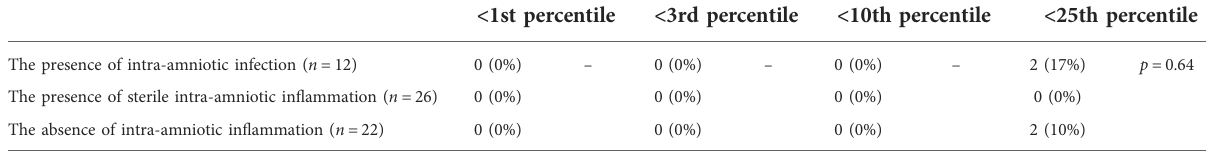
TABLE 3 The rates of newborns with birth weights, expressed as percentiles derived from birth weight standards, that were less than or equal to the 1st, 3rd, 10th, and 25th percentiles from pregnancies with preterm labor with intact membranes prior to a gestational age of 35 weeks with the presence of intra-amniotic infection, presence of sterile intra-amniotic in fl ammation, and absence of intra-amniotic in fl ammation.